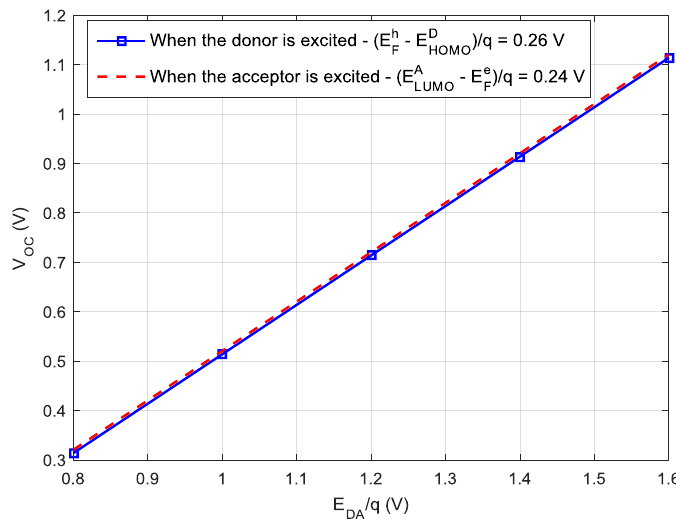
V plotted as a function of effective band gap qE / for non- Figure 3. Open circuit voltage V OC plotted as a function of effective band gap E DA / q for Figure 3. Open circuit voltage OC DA non-optimized P3HT:PC 60 BM with large photocarrier mobility mismatch ( µ e (cid:54) = µ h ) , at energetic   , at energetic optimized P3HT:PC 60 BM with large photocarrier mobility mismatch )( he − E D ) / q = 0.26 V with n = 1.80 × 10 22 m − 3 and ( E A − E e ) / q = 0.24 V with distances ( E h F F HOMO LUMO h )( D  = 0.26 V with n = 1.80 × 10 22 m − 3 and qEE e )( A  = 0.24 V with p = 0.95 × 10 22 m − 3 in the donor and acceptor materials, respectively. distances qEE F HOMO F LUMO p = 0.95 × 10 22 m − 3 in the donor and acceptor materials, respectively. Table 4. The calculated values of open circuit voltage V DA from Equation (18) using the n and p values OC ) upon simultaneous excitation of both listed in Tables 2 and 3, respectively, voltage offset ( E DA / q − V DA OC the donor and acceptor materials, and the corresponding measured open circuit voltage V meas. . OC Active Layer